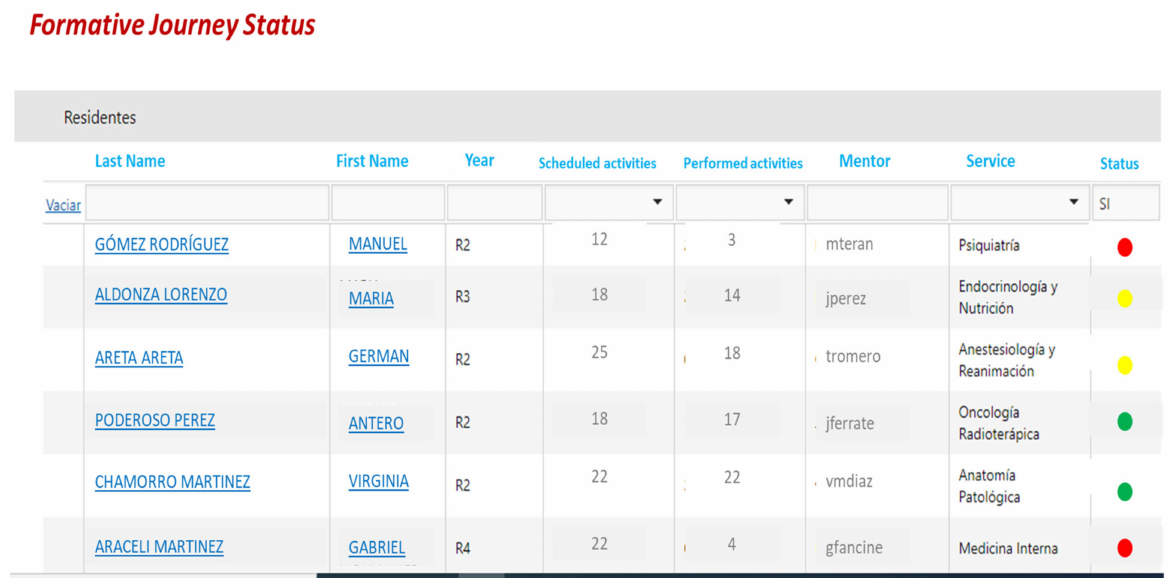
Figure 3. Components Included in the m-Learning App Proposed as a Medical Education Opportunities Self-Management Tool.